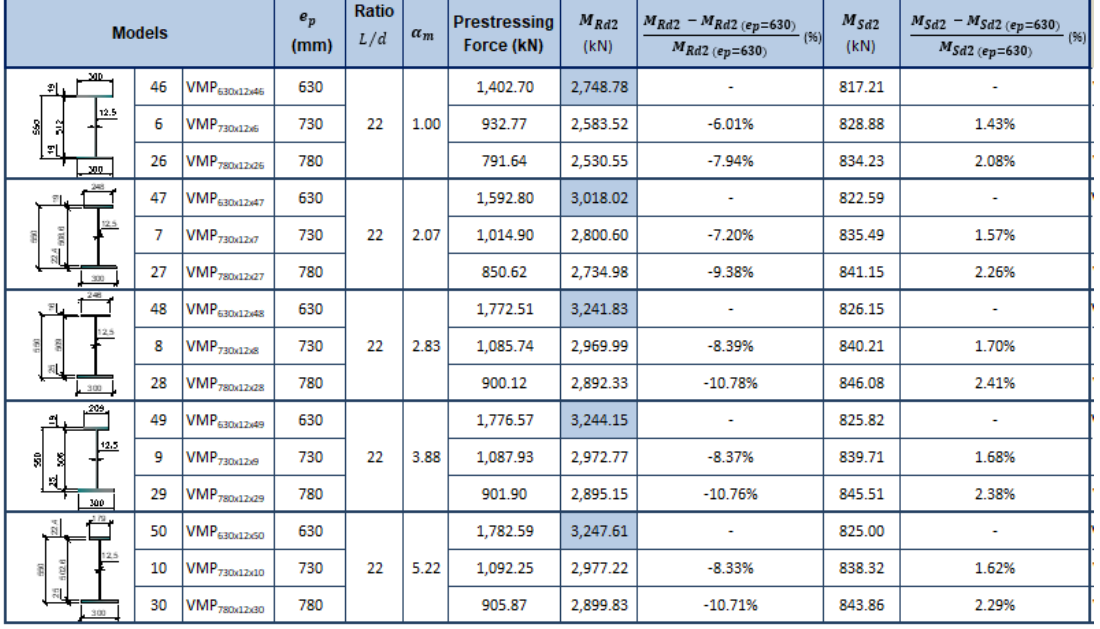
Figure 11. Eccentricity influence -